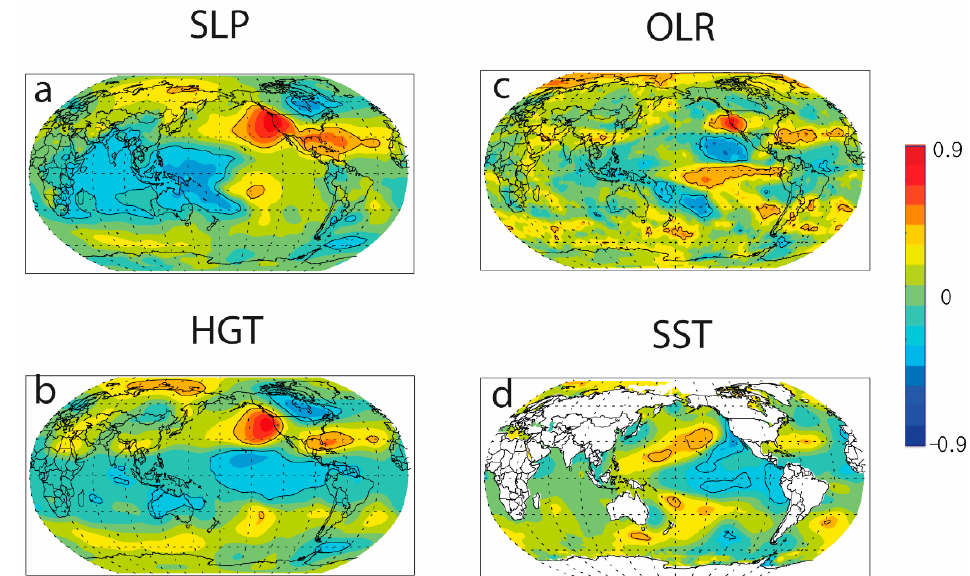
Figure 2. Correlation map of precipitation with ( a ) sea-level pressure, ( b ) geopotential height at 500 hPa, ( c ) outgoing long-wave radiation and ( d ) sea surface temperature for the 41-year (1975–2015). Correlation coefficients are multiplied by ( − 1.0). Black solid lines indicate significance at the 95% confidence level.